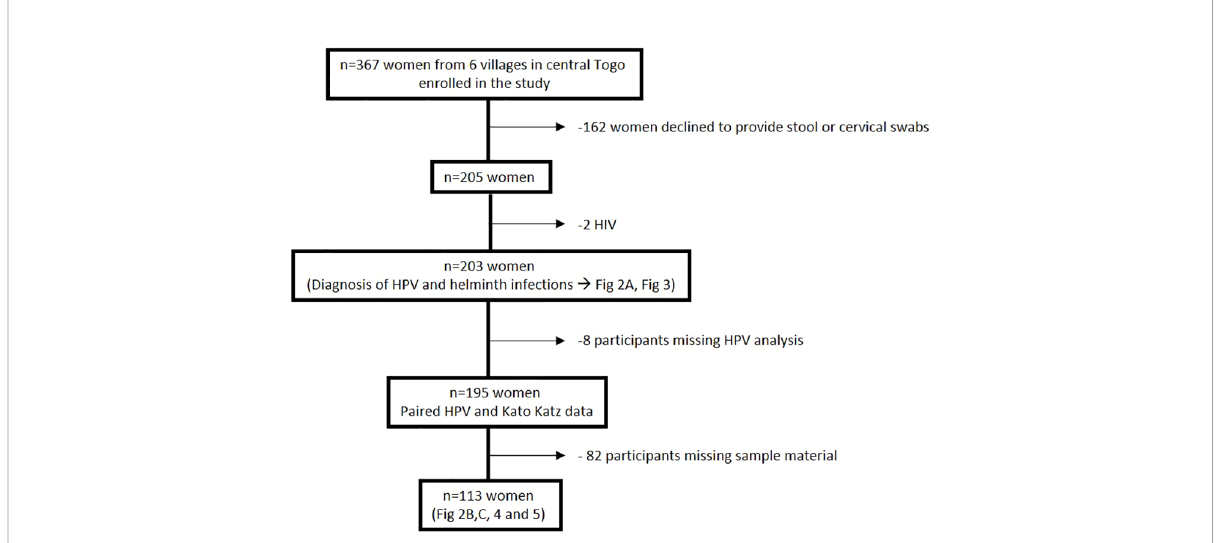
FIGURE 1 Overview of the study cohort from six villages in the Central region of